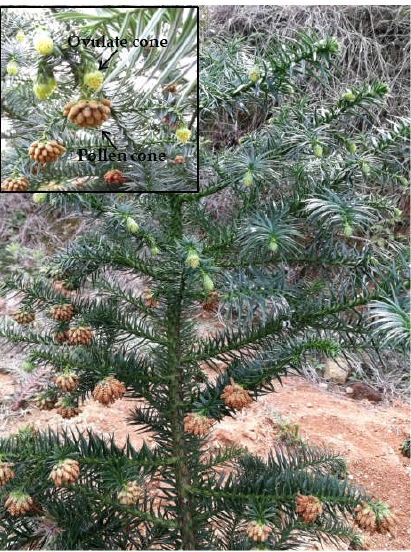
Figure 1. Synchronization in mature of ovulate and pollen cones in clone cx569 of Chinese fir.